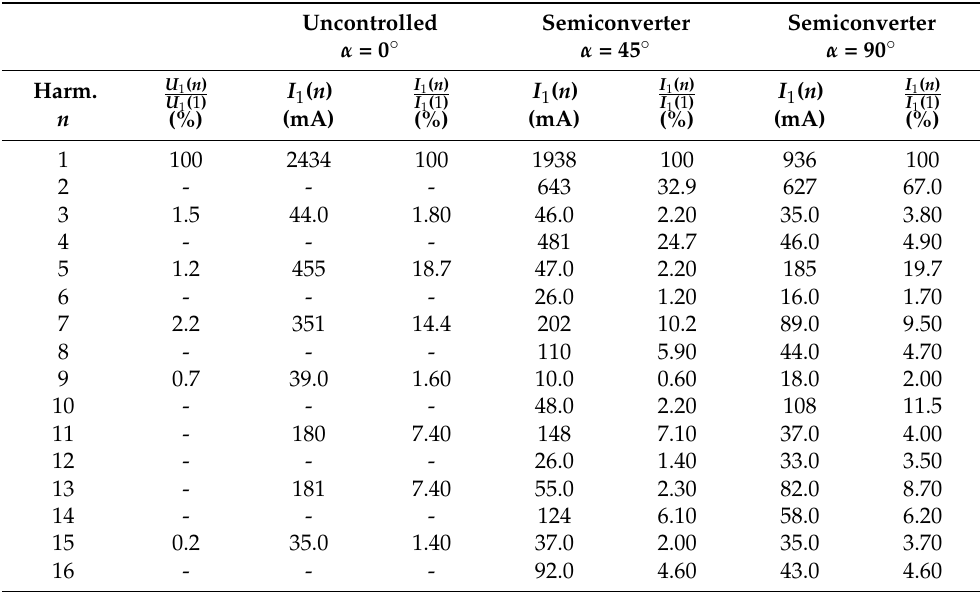
Figure 11. Recorded voltage and current waveforms of the grid side ( a ) and corresponding u–i characteristic ( b ) of the uncontrolled rectifier. Table 1. Spectral analysis of the AC current I 1 and of the phase voltage U 1